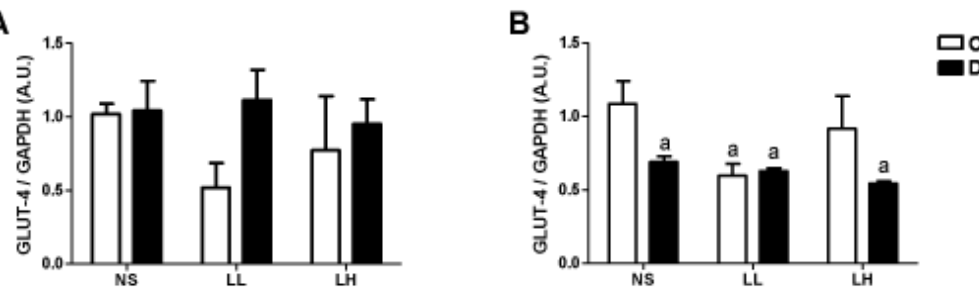
Figure 2. GLUT-4 gene expression in ( A ) soleus and ( B ) EDL muscles Values are expressed as mean ± S.E.M. a Different from CON-NS ( p <